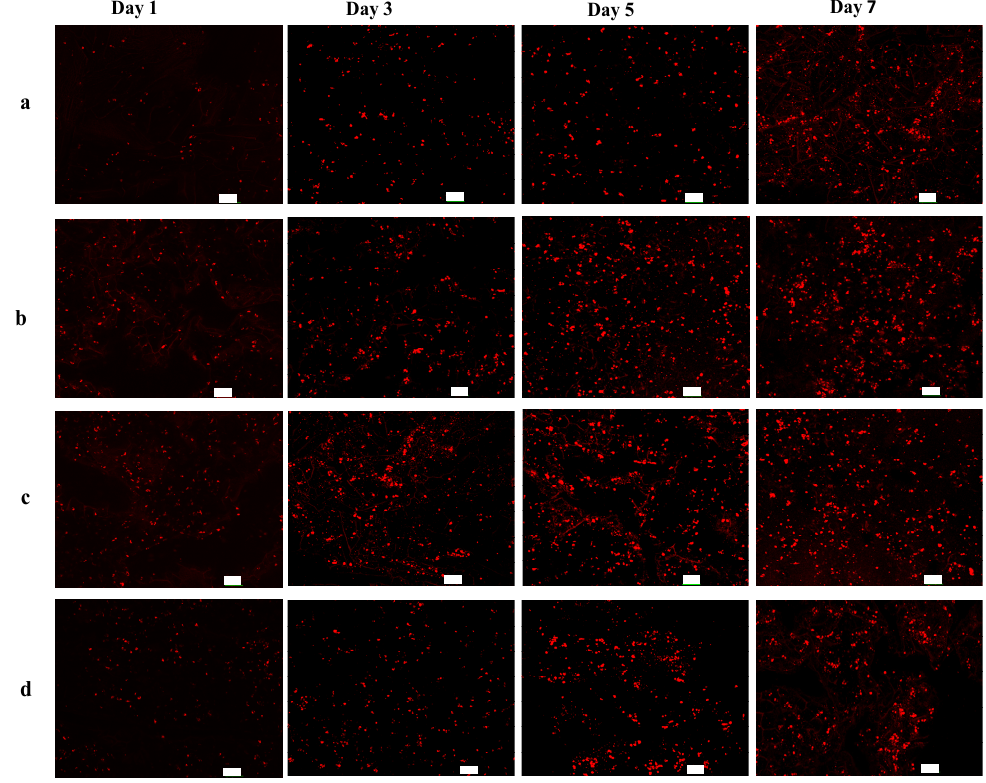
Figure 3. Fluorescence microscope images of CM ‐ Dil stained BSF scaffolds seeded with EA. hy926 cells on days 1, 3, 5 and 7. Proportions of ASF micro/nano fibers: ( a ) 0; ( b ) 50%; ( c ) 150%; ( d ) 250%. Scale bar: 100 μ m.